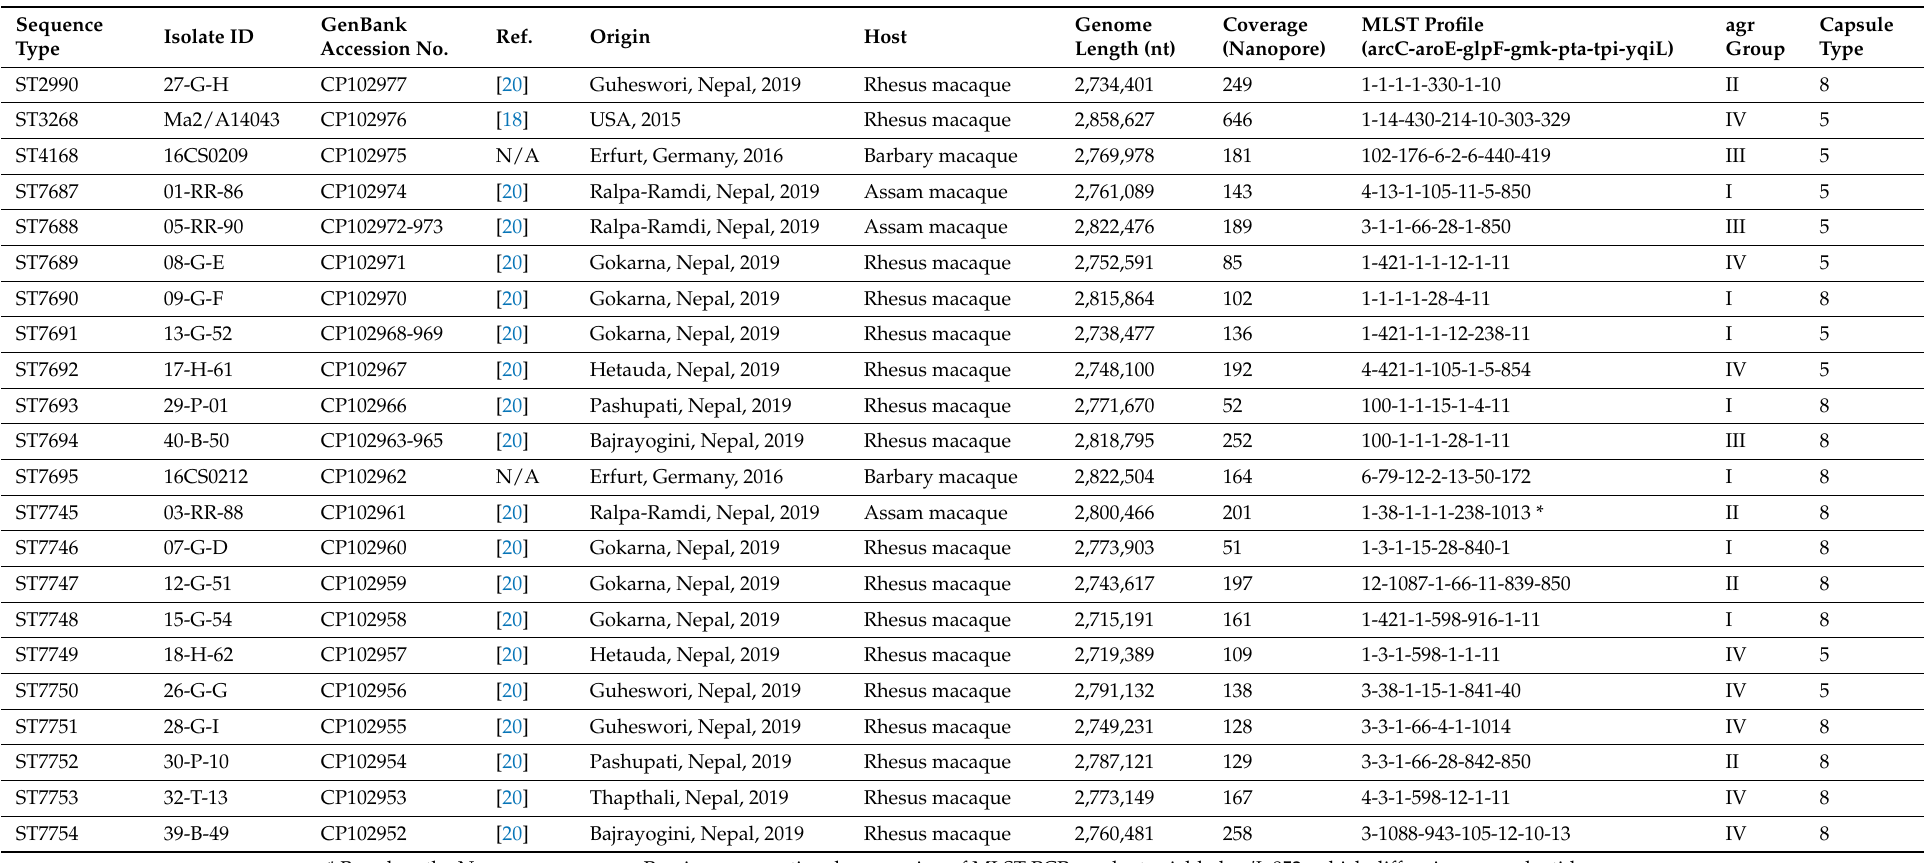
Table 1. Origin and typing data of study